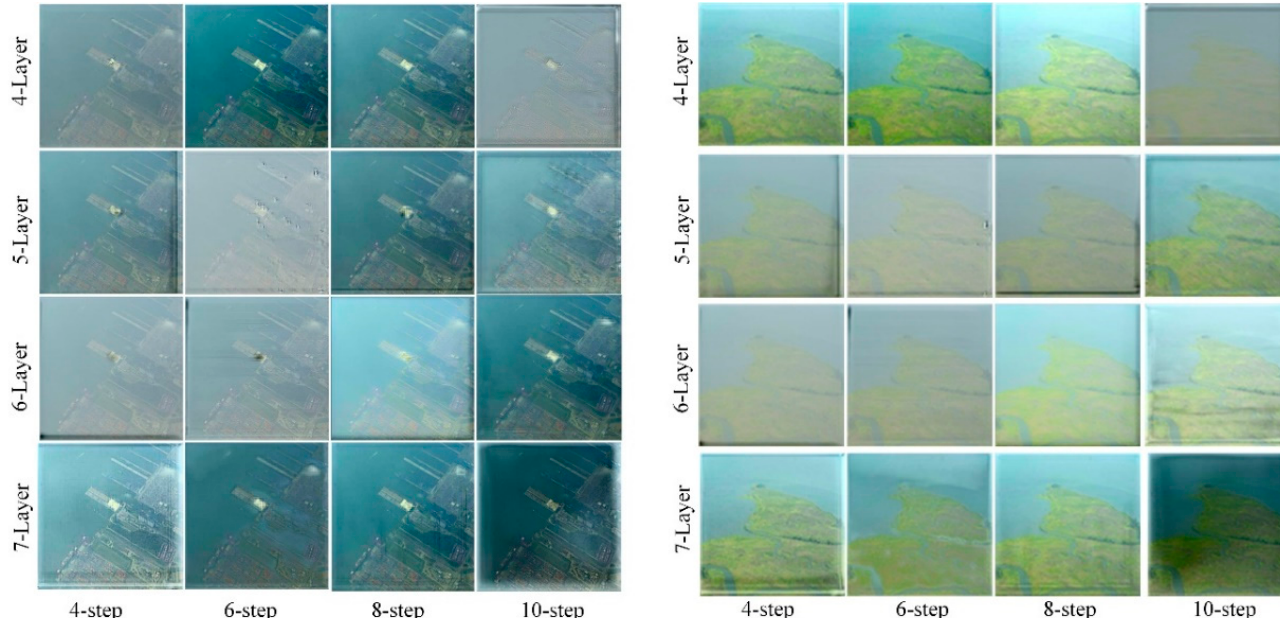
Figure 19. Results of foggy images according to the number of layers and steps.